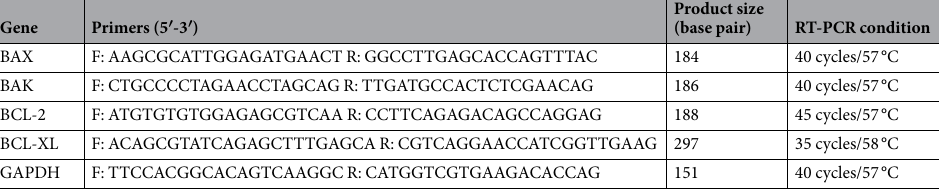
Table 4. Primers used for RT-PCR analyses. Note: F: forward primer; R: reverse